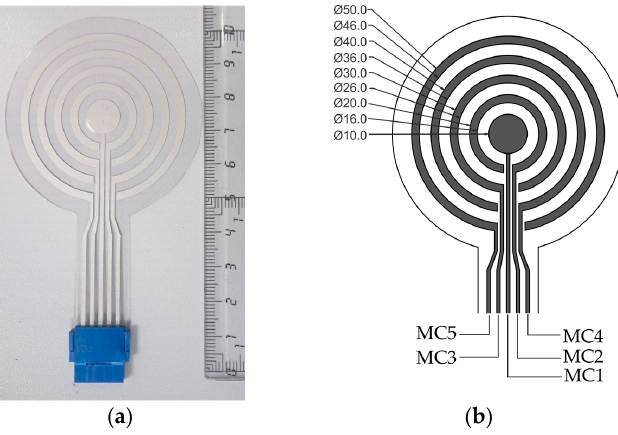
Figure 1. ( a ) Multi-ring concentric electrode; ( b ) Dimensions (in mm) of poles and annotation of signals sensed by each pole.